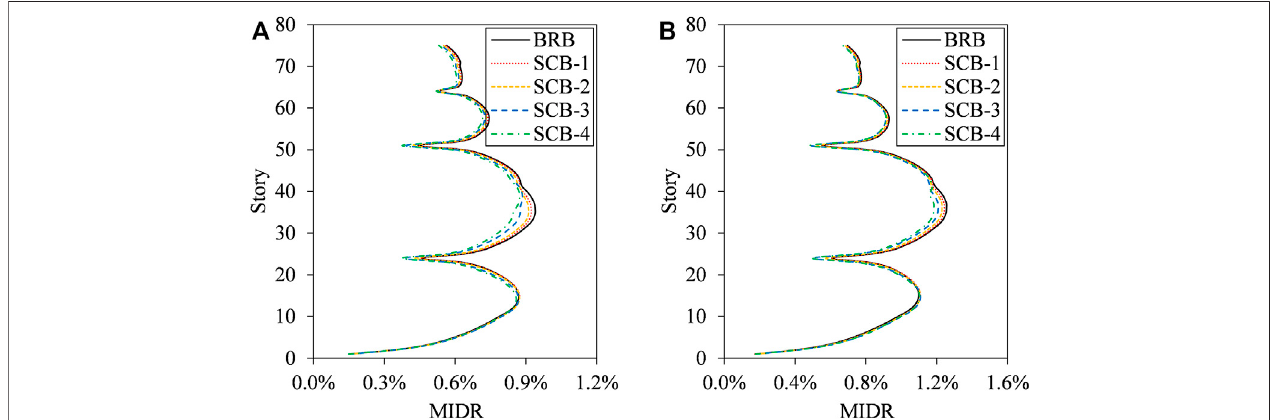
FIGURE 13 | Comparison of distribution of MIDR of study cases. (A) PGA = 400 cm/s 2 . (B) PGA = 510 cm/s 2 .